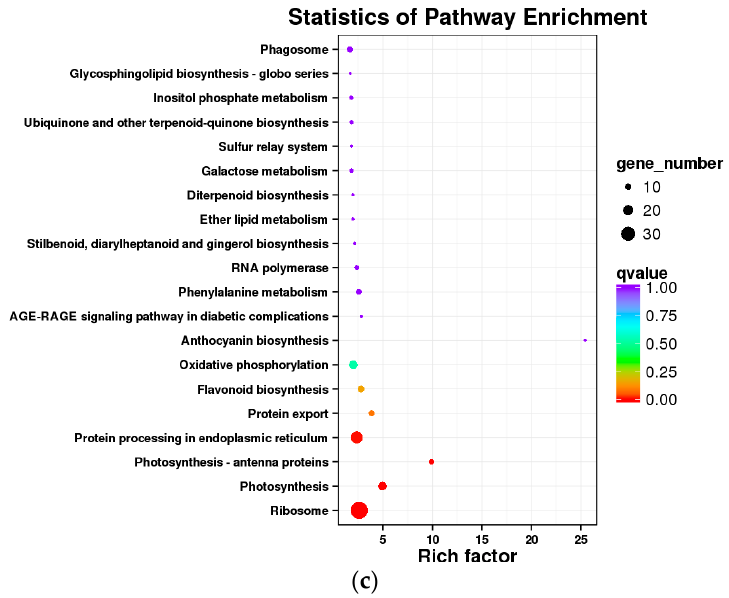
Figure 7. KEGG enrichment analysis of the differentially expressed genes between L, M, and H at the E-L 35, E-L 36, and E-L 38 stages, respectively ( a – c